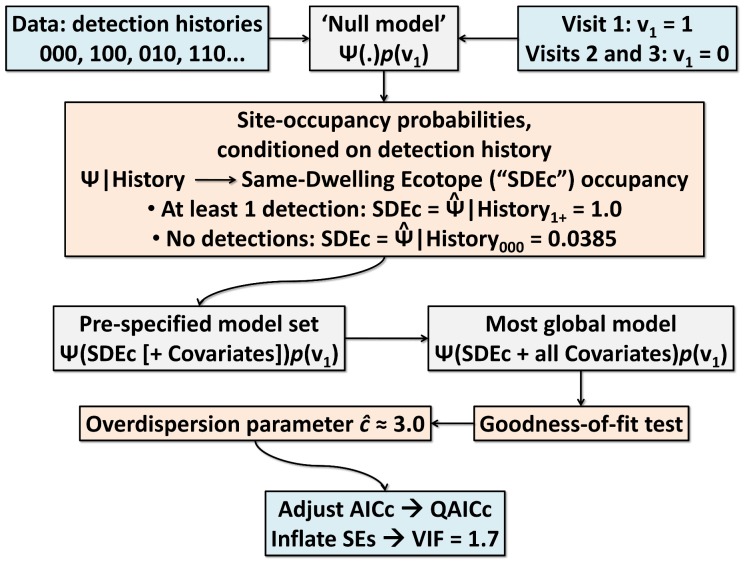
Ecology of synanthropic Triatoma b. brasiliensis: Flow chart illustrating the site-occupancy modeling strategy.